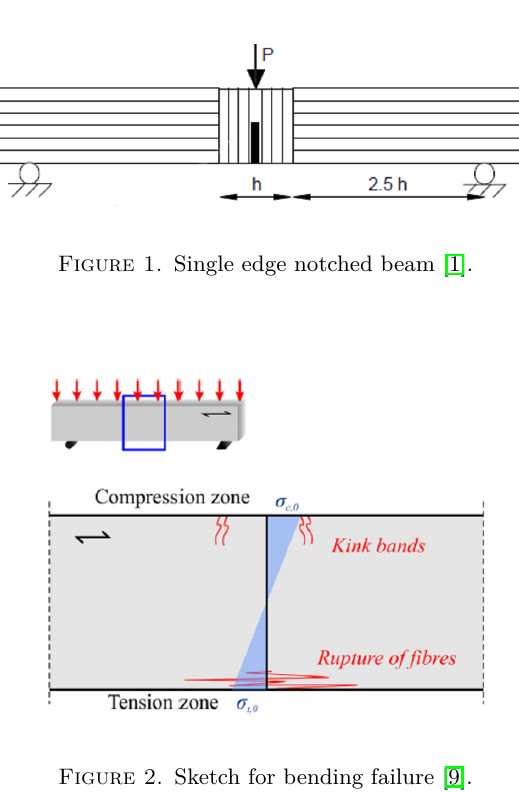
Figure 2. Sketch for bending failure